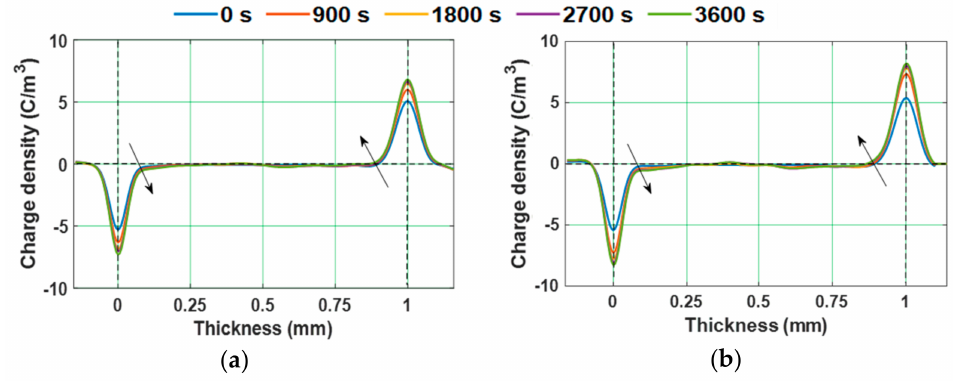
Figure 6. Space charge distribution during poling in ( a ) unaged and ( b ) 8 kGy gamma irradiated epoxy micro-nano composites under 10 kV positive DC voltage [29].